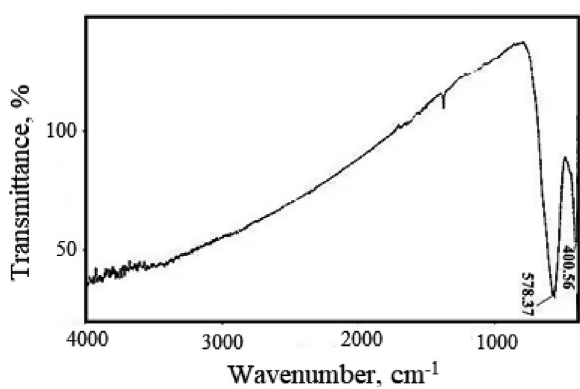
Fig. 2. FTIR analysis of CFNC